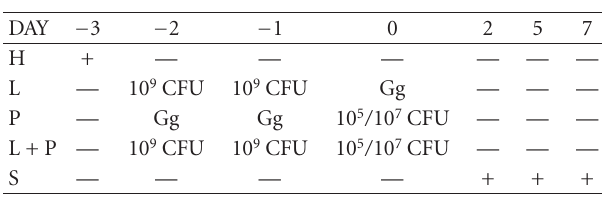
Figure 1: Scheme of inoculation of L. paracasei CRL 1289 and Staphylococcus aureus on Balb/c mice. H: hormone (estradiol valer- ate), L: lactobacilli inoculation, P: pathogen inoculation, L + P: lac- tobacilli plus pathogen inoculation, S: sacrifice of animals, and Gg: glycogelatin ovules without